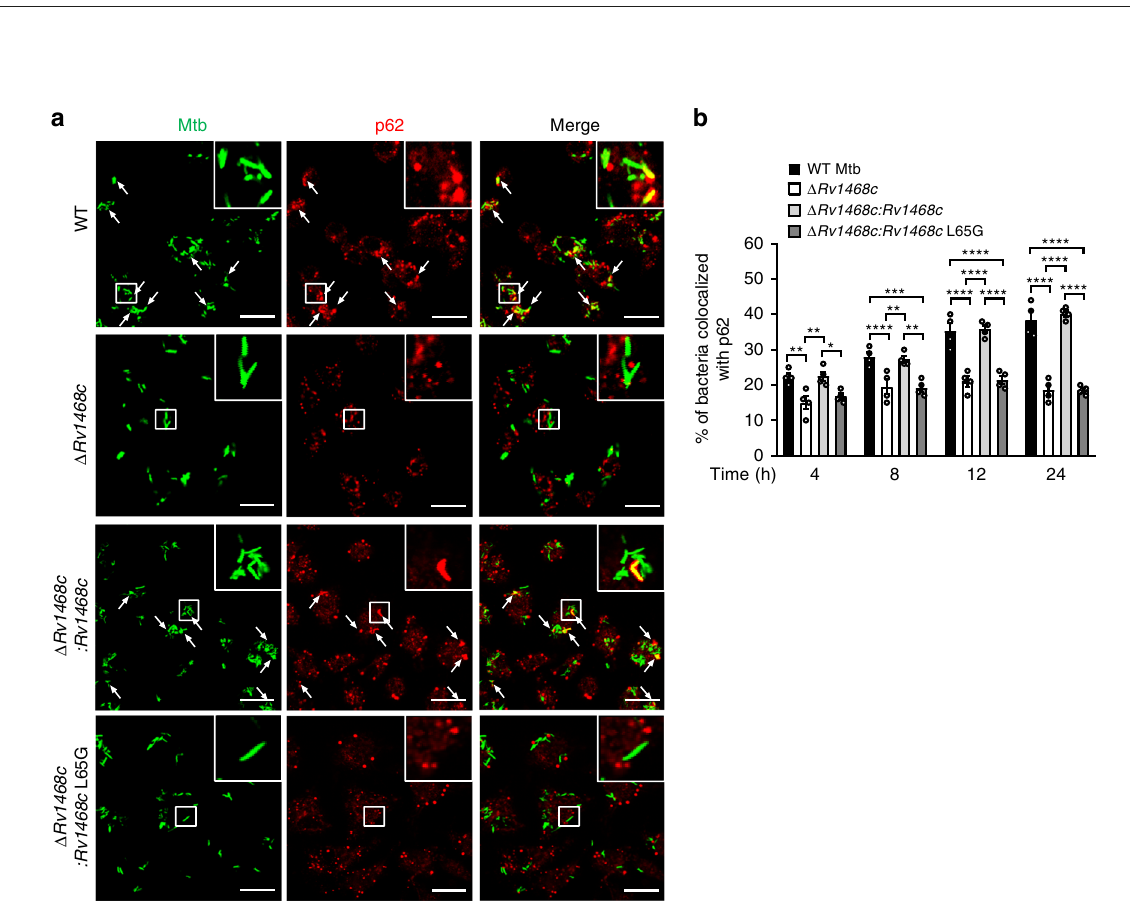
Fig. 6 Rv1468c is required for host p62 targeting to Mtb in macrophages. a Confocal microscopy analysis for colocalization of Mtb with p62 in BMDMs. BMDMs were infected with the indicated Mtb strains at MOI = 5 for 24 h and were then immunostained using anti-p62 antibody (red). Bacteria (green) were prestained with Alexa Fluor 488 succinimidyl ester before infection. Arrows indicate the colocalization of bacteria with p62. Inserts (enlarged views) show representative mycobacteria colocalized with p62. Scale bars, 20 µ m. b Percent colocalization of Mtb with Ub in BMDMs treated as in a for 0 – 24 h. A total of 100 bacterial cells were counted. * P < 0.05; ** P < 0.01; *** P < 0.001; **** P < 0.0001 (two-way ANOVA). Results are representatives from three independent experiments (mean ± s.e.m. of n = 4 in b ). The source data used in b are provided in Source